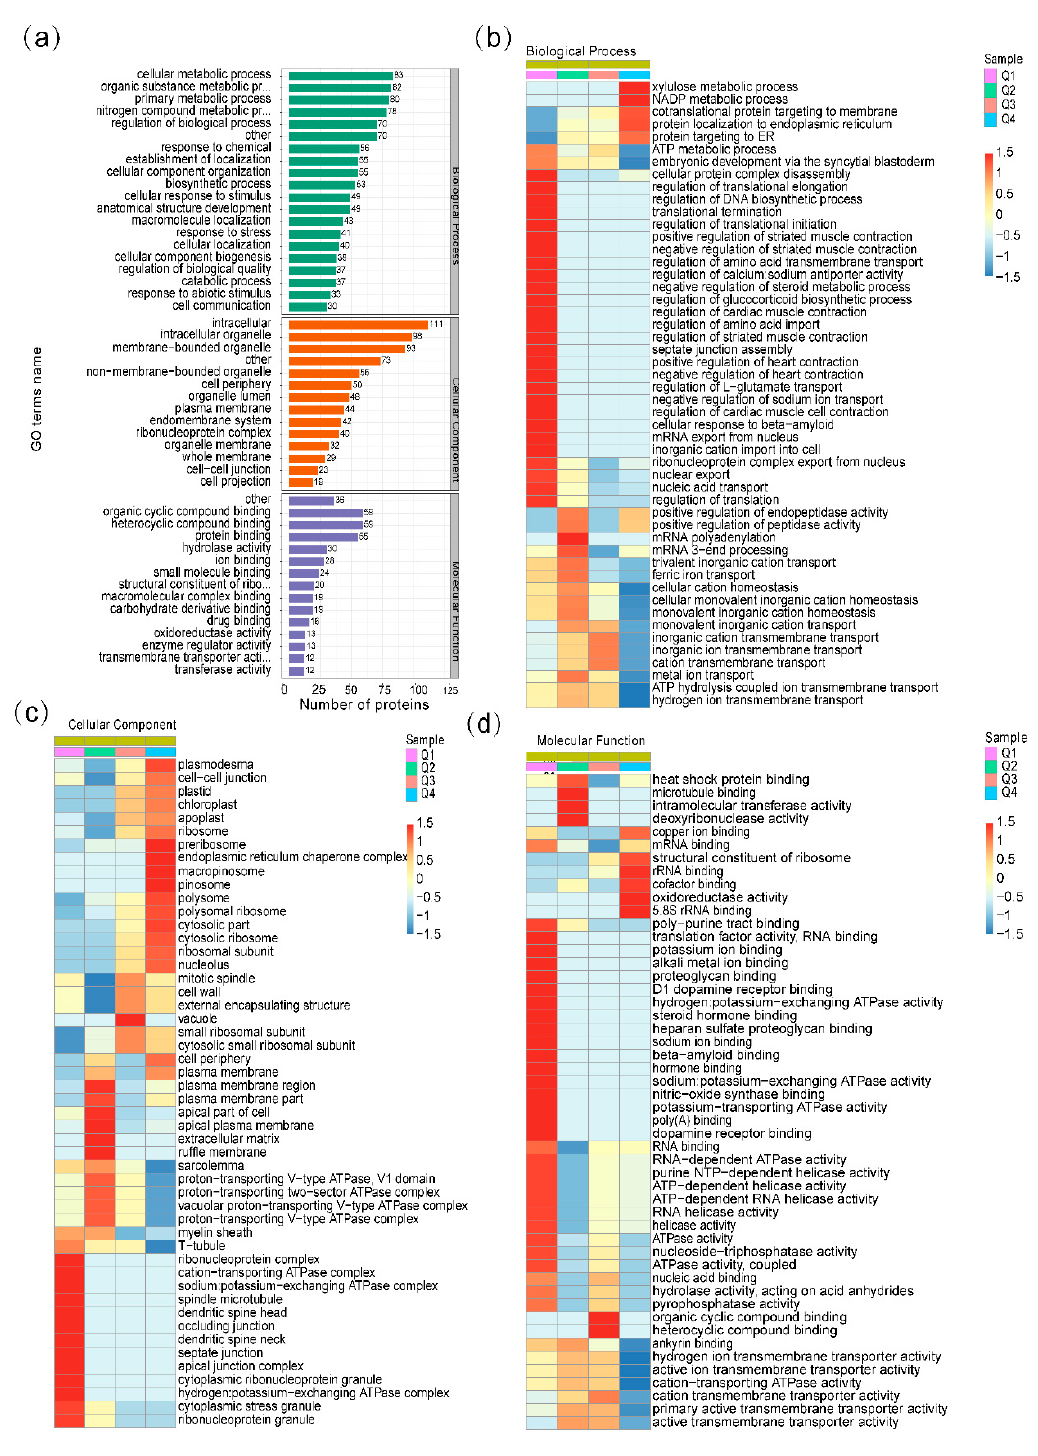
Figure 3. GO functional classification and GO enrichment-based clustering analysis. ( a ) GO functional classification of the di ff erential ubiquitinated proteins based on gene ontology; ( b – d ) GO enrichment-based clustering analysis of the di ff erentially ubiquitinated proteins. Those categories at least enriched in one of the clusters with p value < 0.05 were clustered. The p value matrix was transformed by the function x = − log10 ( p value), and was then z-transformed for each category. These z scores were clustered by one-way hierarchical clustering and visualized by a heat map using R-package. ( b ) Biological process analysis; ( c ) cellular component analysis; ( d ) molecular function analysis. To better reveal the changes of ubiquitinated protein in response to heat stress, GO enrichment- based clustering analyses were performed by dividing all the differentially expressed ubiquitinated